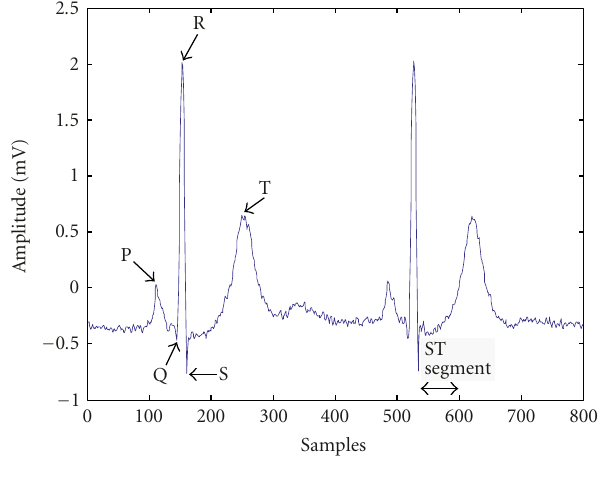
Figure 1: A typical human’s ECG signal.